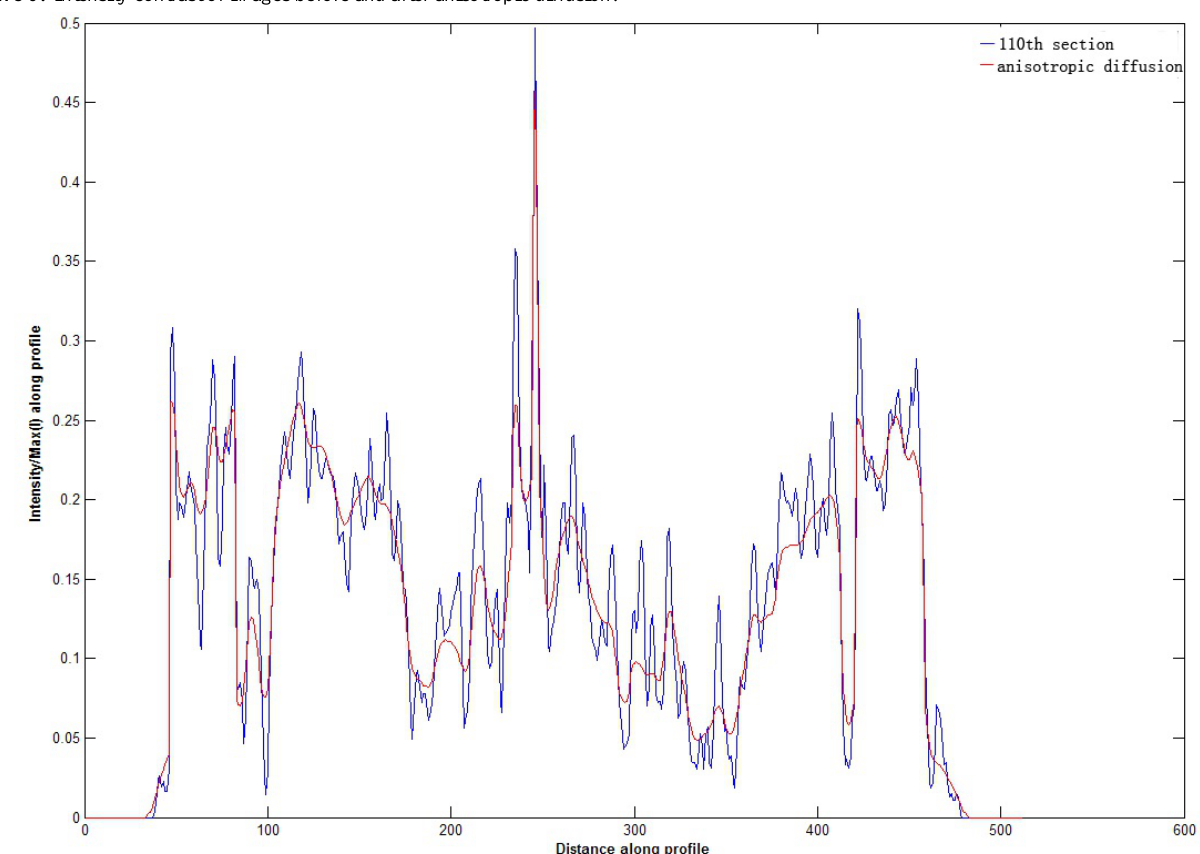
Figure 6. Intensity contrast of images before and after anisotropic